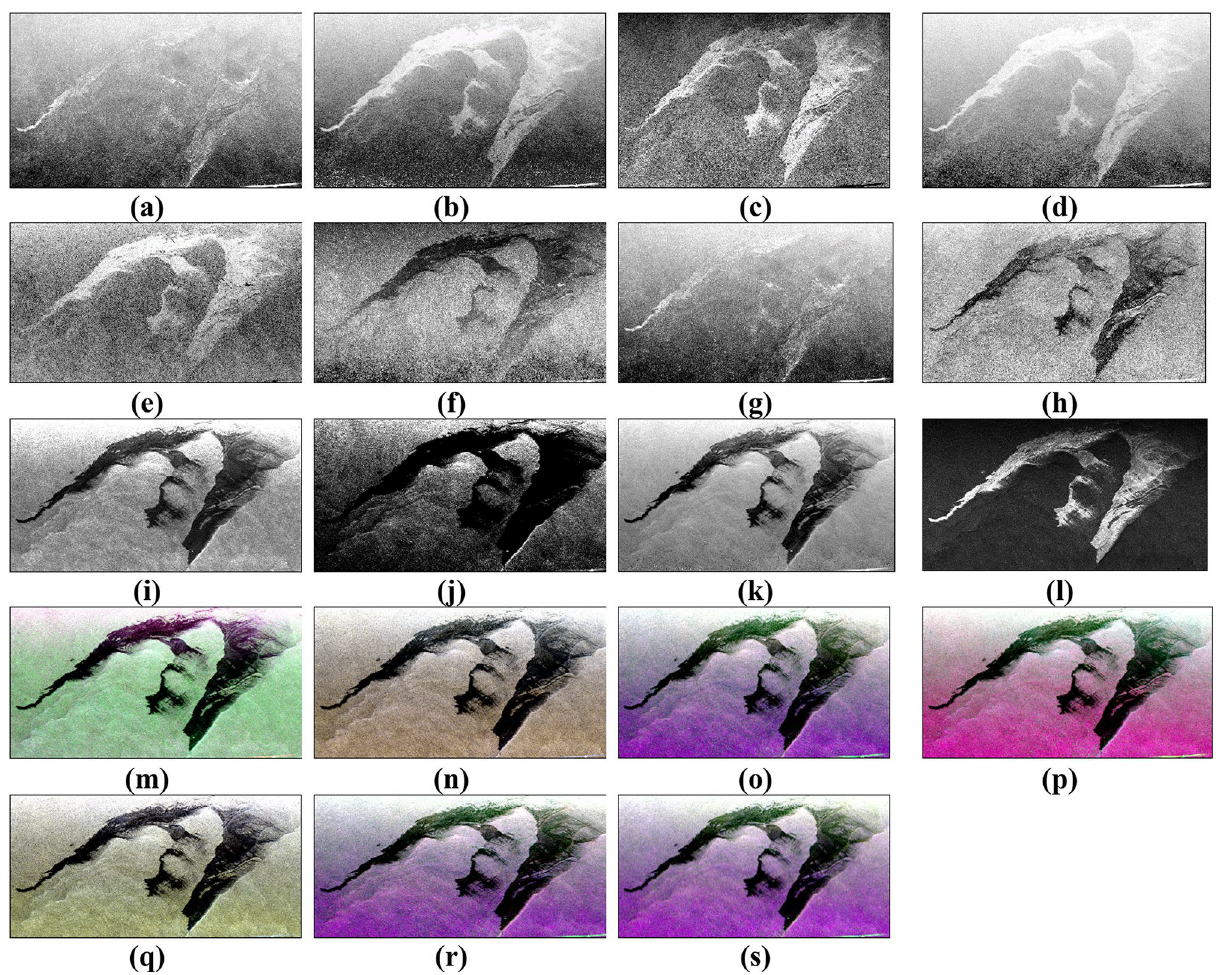
Figure 7. Representation of calculated polarimetric parameters ( a ) Entropy, ( b ) Anisotropy, ( c ) Conformity Coefficient, ( d ) DERD, ( e ) SERD, ( f ) Pedestal Height, ( g ), Scattering Diversity, ( h ) Alpha, ( i ) (cid:31) , ( j ) (cid:31) 3 , ( k ) Shannon Entropy, ( l ) VV Damping ratio, ( m ) Pauli RGB of Coherency matrix, ( n ) LHV, ( o ) LHV Compact-pol decomposition, ( p ) LHV Raney decomposition, ( q ) RHV, ( r ) RHV Compact-pol decomposition and, ( s ) RHV Raney